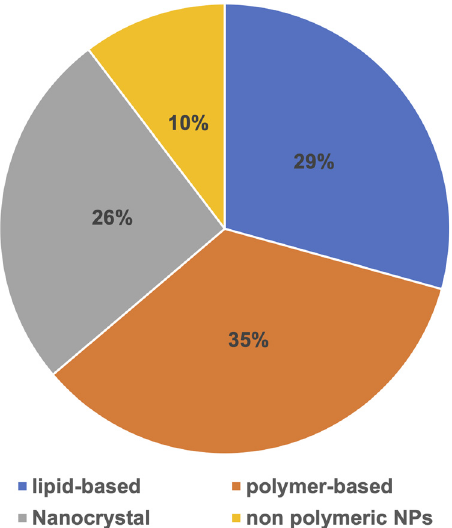
Figure 2: The percentage distribution of approved nanoparticle medications in the global